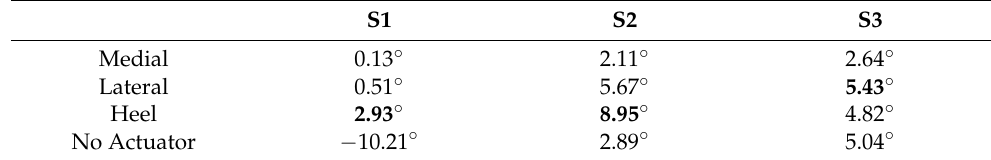
Table 3. Average difference in knee angle vs. actuator location during stance.